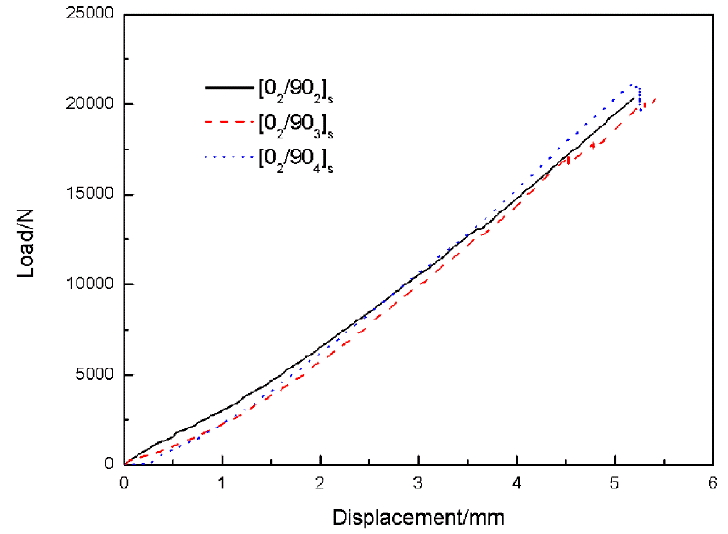
Figure 6. Typical load–displacement curves for the test samples.